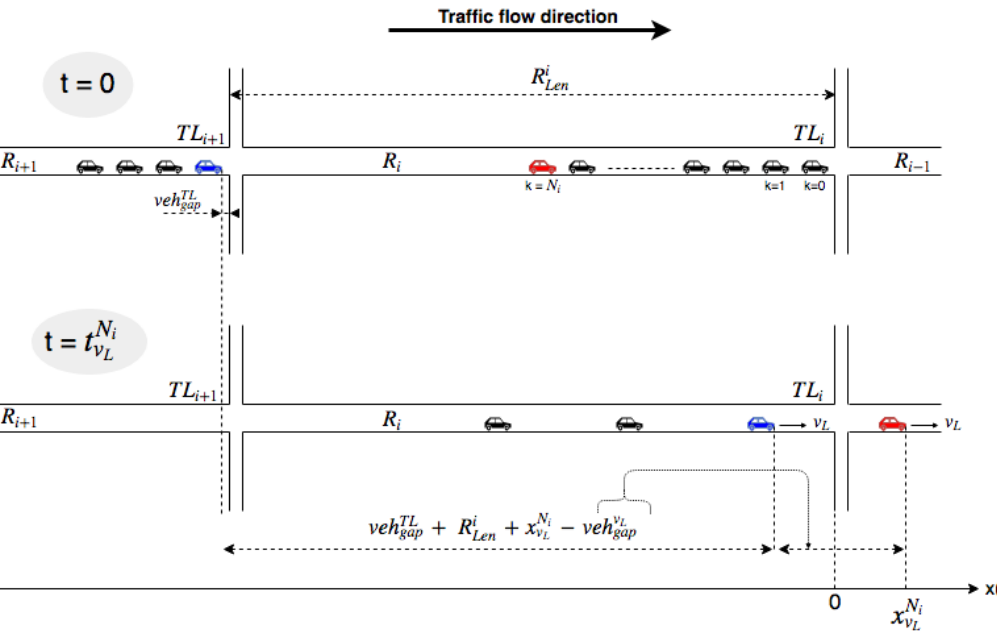
Figure 7. Illustration of adjacent traffic lights synchronization